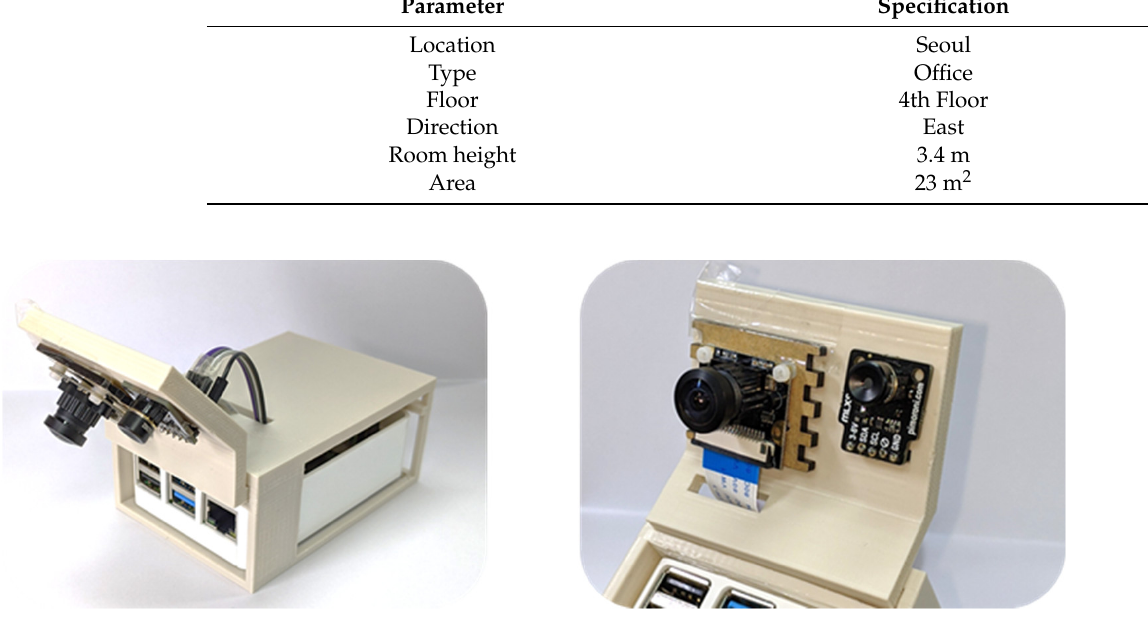
Figure 6. Raspberry Pi with image sensors.